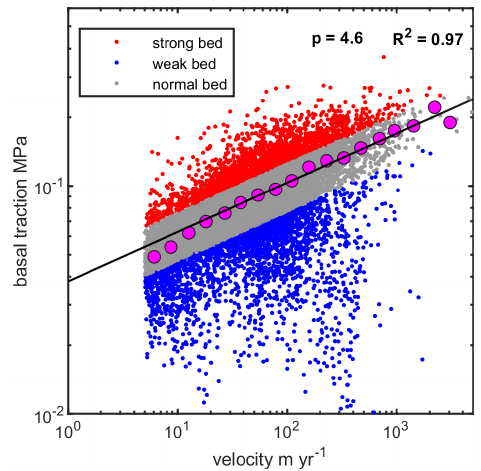
Figure 7. Weak- and strong-bed delineation is presented based on residuals from ice-sheet-wide flow relationship. Ice-sheet-wide flow relationship (black line) is calculated by averaging the SIA, SSA, and FS traction estimates for each grid cell in the likely thawed re- gions and fitting a power-law model to the binned data. Pink mark- ers show the binned velocity–traction relationship (median, 20 bins, logarithmically spaced). The residuals from the model relationship are used to delineate and map bed strength throughout Greenland. Strong and weak beds comprise the bottom and top 15% percent of the log-residual distribution, while grid cells with normal bed strength occupy the middle